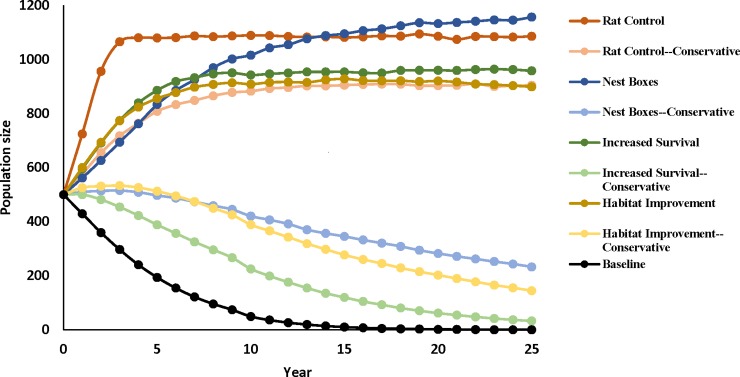
Population trajectories of baseline and management models in Vortex.